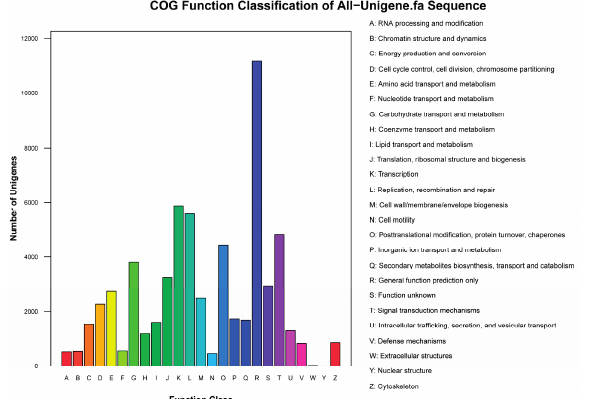
Figure 4. COG (Cluster of Orthologous Groups of proteins) classification of the P. fortunei all unigenes. 32,269 unigenes (28.0% of the total) were annotated and grouped into 25 specific